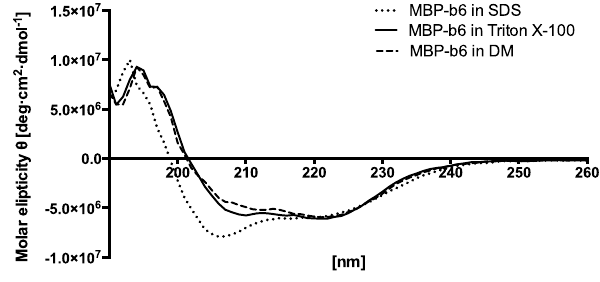
Figure 1. Circular dichroism spectra of MBP-cytochrome b 6 fusion protein in different detergent solutions.